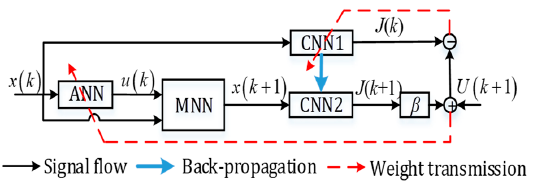
Figure 11. The description of the structure of ADP.